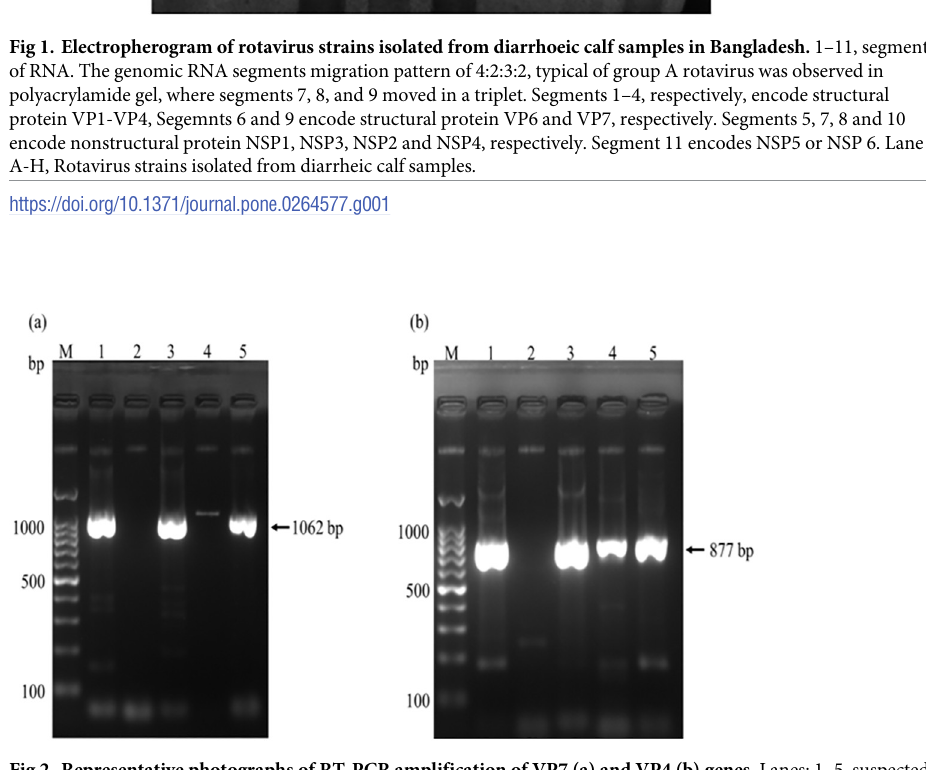
PLOS ONE | https://doi.org/10.1371/journal.pone.0264577 February 25,